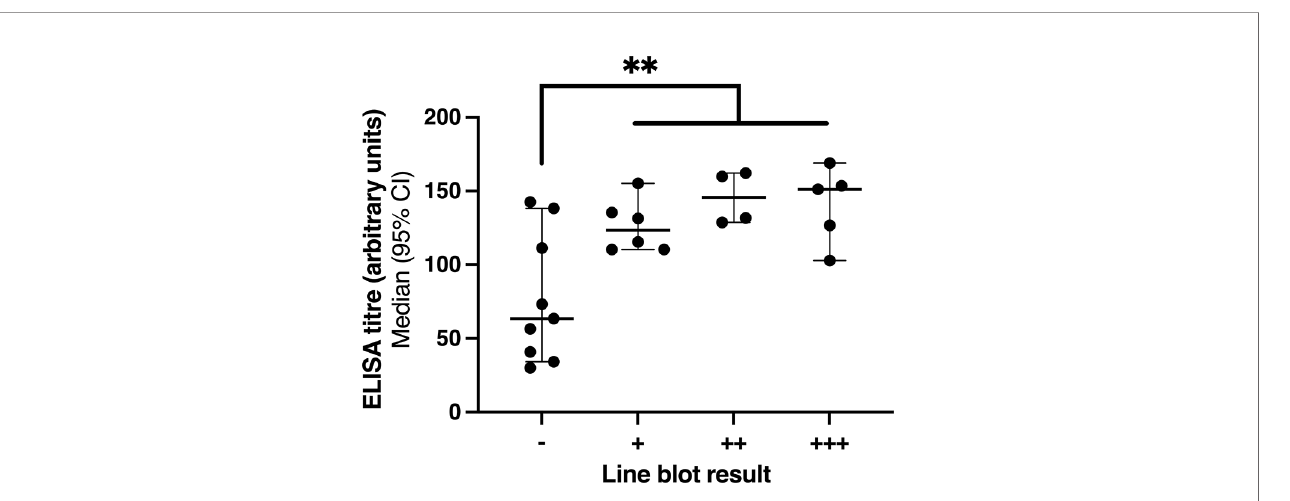
FIGURE 2 | Comparison of anti-TIF1 g ELISA titre and line blot result. **P ≤ 0.01.